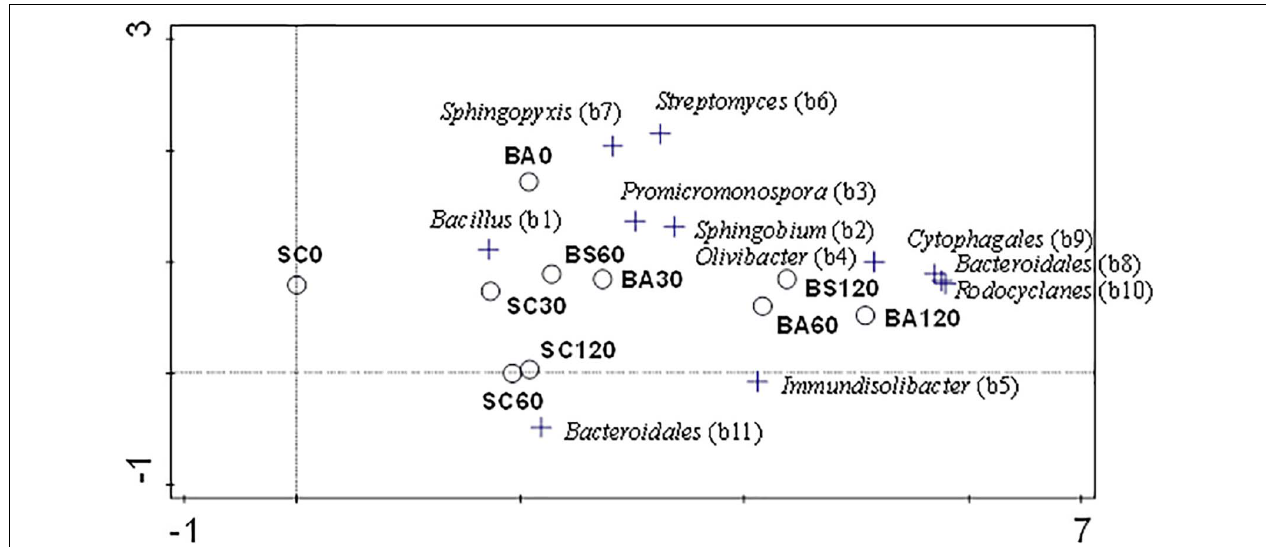
FIGURE 6 | Detrended correspondence analysis (DCA) on the relative DGGE band intensity of bacterial ribotypes from microcosm samples taken at different time and with treatments, as detected from the DGGE profiles ( Figure 5 ). Only those bands with a relative band intensity higher than 1% were considered.